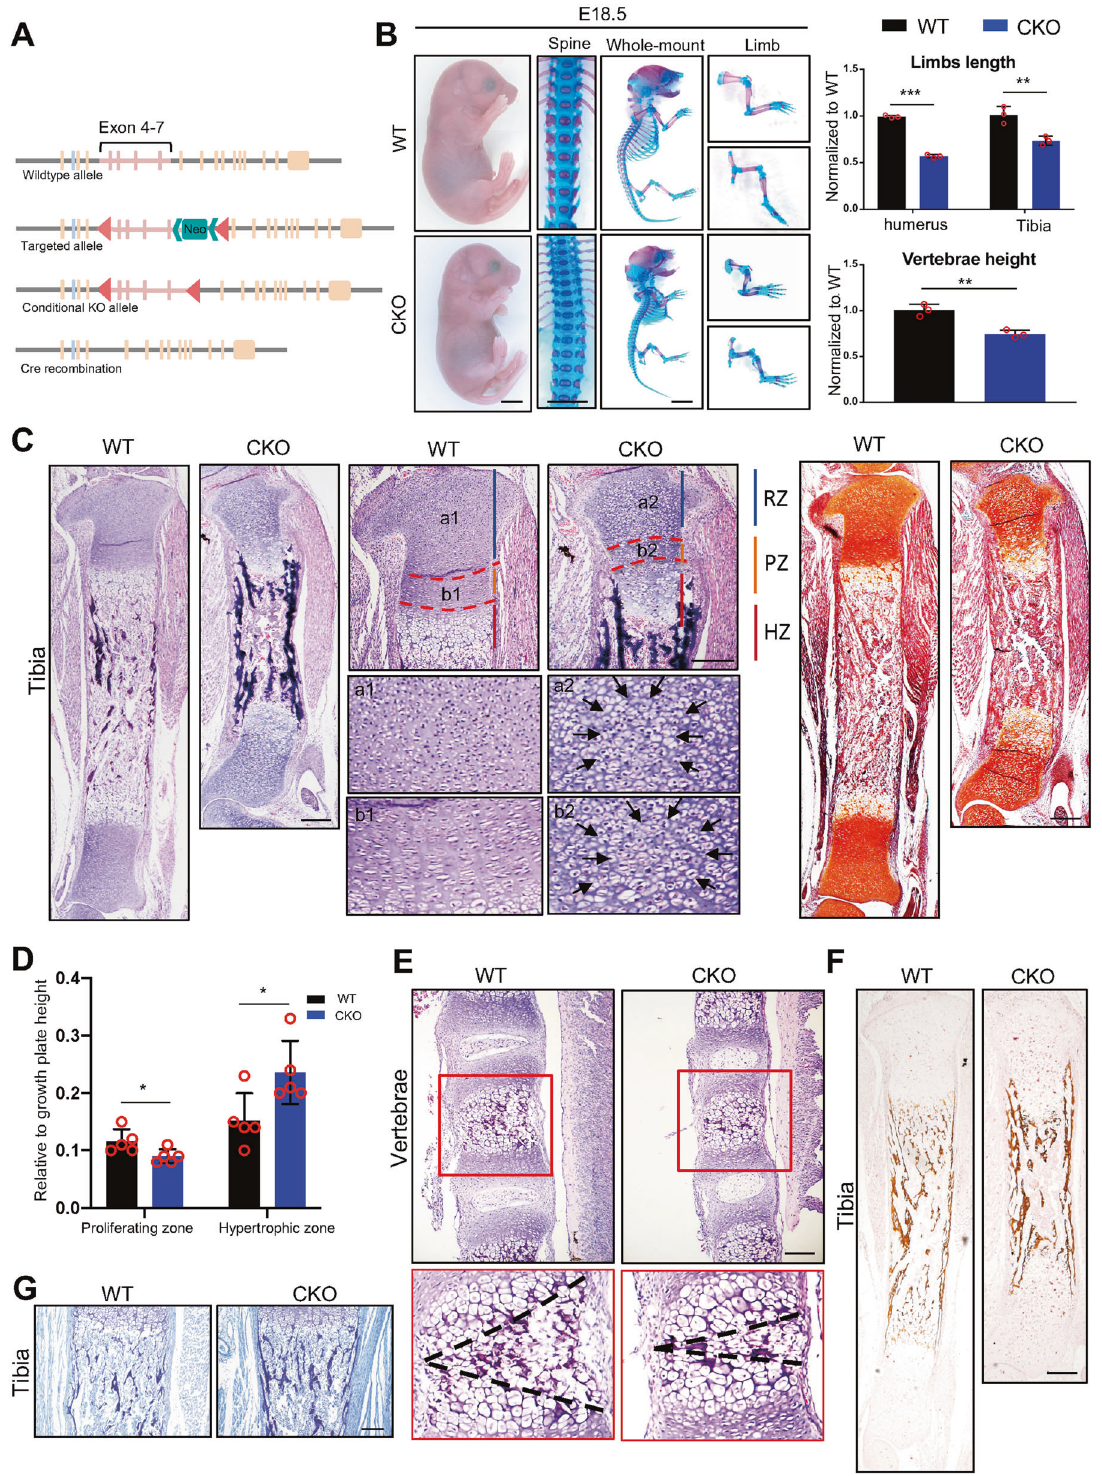
Fig. 1 Ablation of Hnrnpk results in the occurrence of dwar fi sm and abnormal growth plate development. A Schematic diagram of the strategy constructing Hnrnpk loxP mice. B General inspection and skeletal preparation of E18.5 WT and CKO embryos (left panel) and quanti fi ed comparison of limbs length and vertebrae height between E18.5 WT and CKO embryos (right panel). n = 3 biological replicates. Scale bar: 1 mm. C H&E staining (left panel) and Safranine O staining (right panel) of tibia of E18.5 WT and CKO embryos. Black arrows: atypical chondrocytes in resting and proliferating zones. Scale bar: 100 μ m. D Quanti fi cation of the height of proliferating zone and hypertrophic zones according to H&E staining of tibia of E18.5 WT and CKO embryos. n = 5 biological replicates. E H&E staining of lumbar vertebrae of E18.5 WT and CKO embryos. Red boxes: magni fi cation of vertebral growth plate. Black dotted lines: range of ossi fi cation center. Scale bar: 100 μ m. F , G von Kassa staining ( F ) and Toluidine blue staining ( G ) of tibia of E18.5 WT and CKO embryos. Scale bar: 100 μ m. p -value was calculated by two-tailed unpaired Student ’ s t -test. Data were shown as mean ± SD. * p < 0.05; ** p < 0.01; *** p < 0.001. Cell Death and Disease (2022)